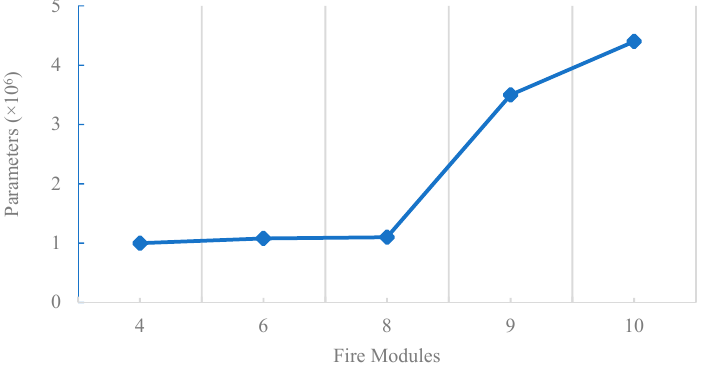
Figure 10. Number of parameters of SqueezeNet with respect to Fire modules.